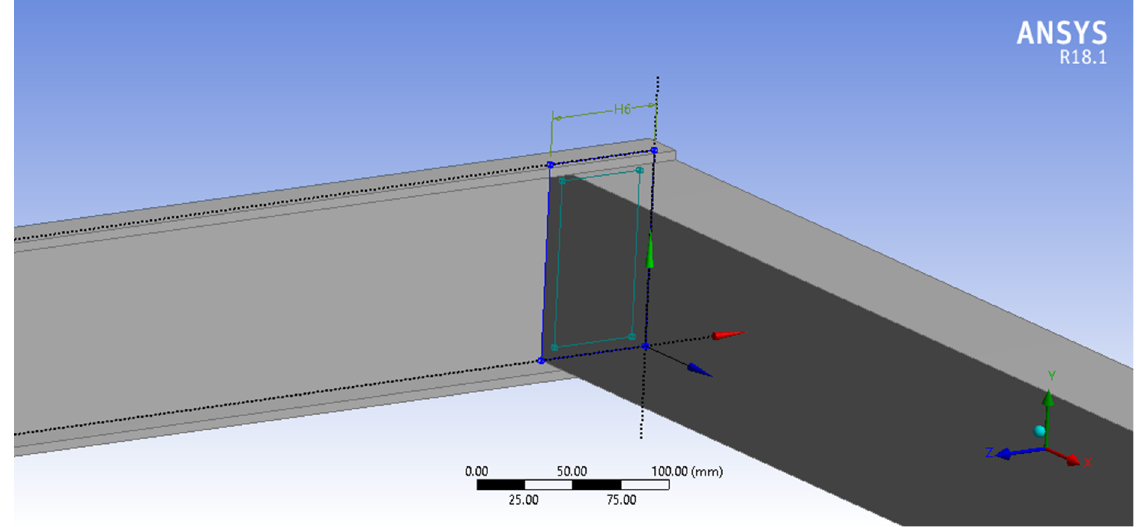
Figure 9. H6 dimension (cross member width) selected for optimization.